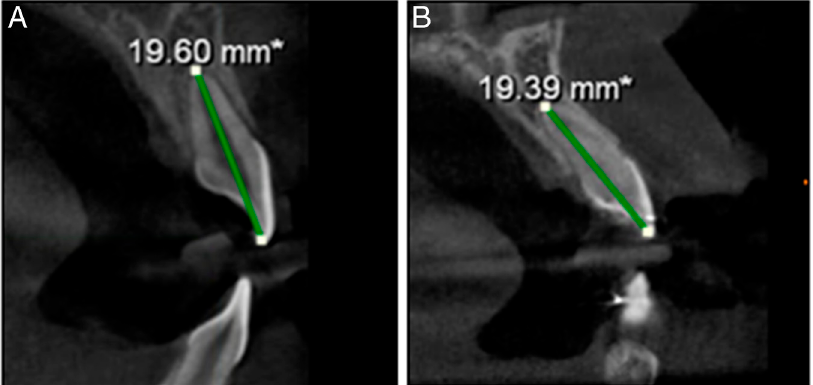
Figure 13. Root length of the control tooth 21 on the cone-beam computed tomography (CBCT). (A) Pre-op root length was 19.60 mm; (B) Post-op 21 root length was 19.39